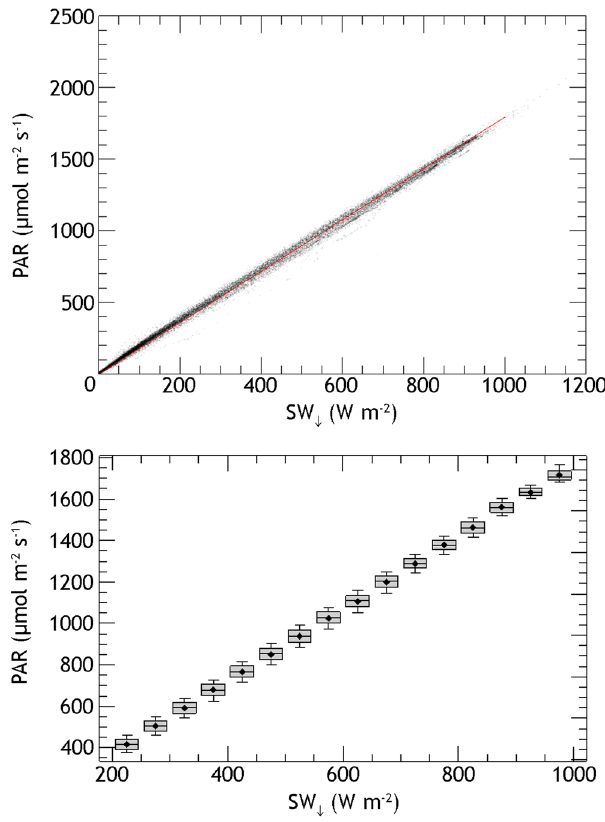
Figure 7. Relationship between PAR and SW ↓ : (top) measured PAR and SW ↓ and their linear fit (red line); (bottom) boxplot graph with the binning approach used. The scaling factor f is the mean of ratio of the mean PAR and the mean SW ↓ for each